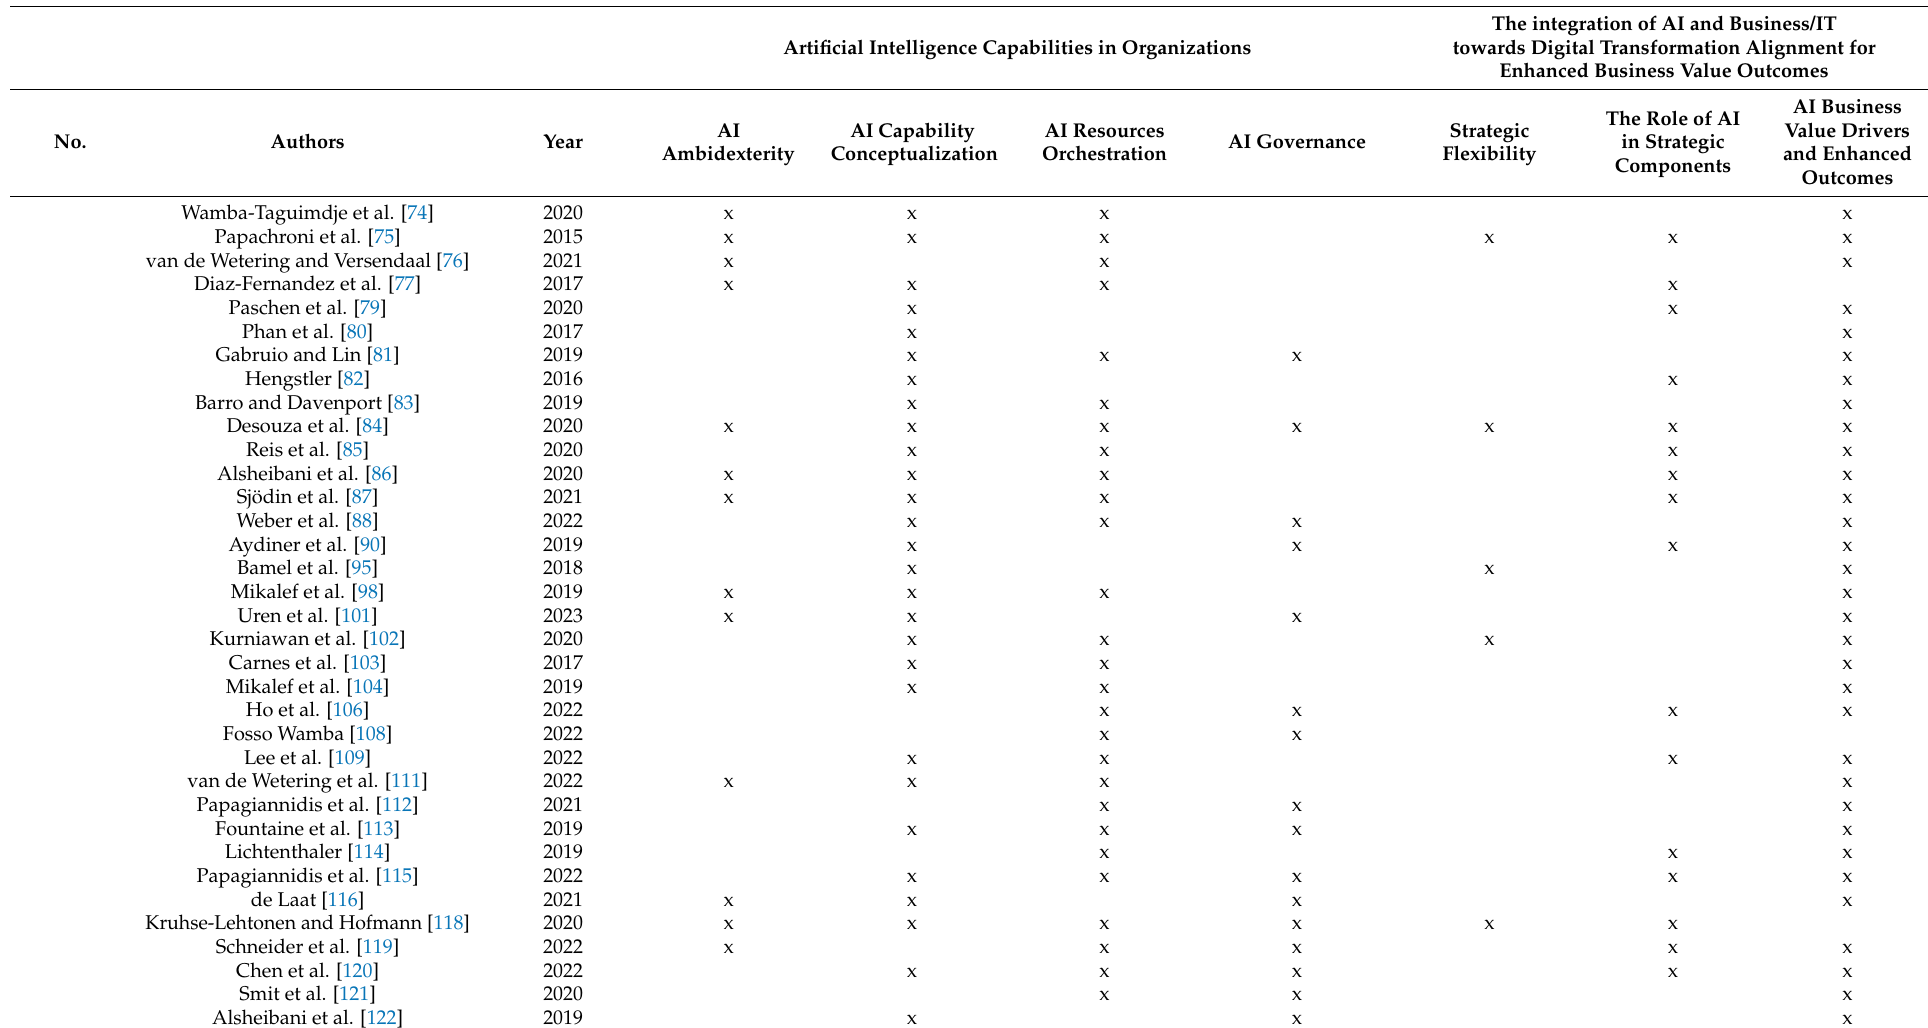
Table A3. Concept matrix table. Source: Own